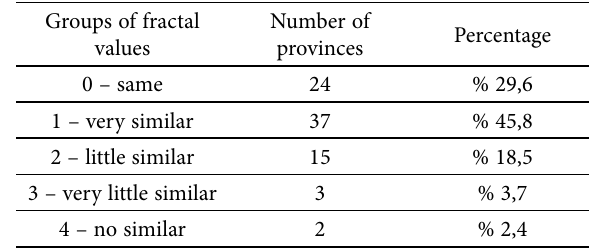
Table 6. Distribution of provinces to groups of fractal